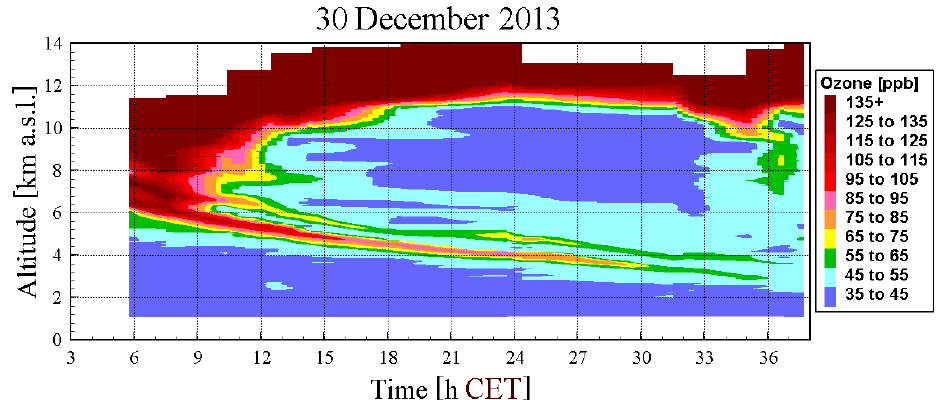
Figure 4. DIAL ozone soundings on 30–31 December 2013 showing two narrow layers descending parallel to below